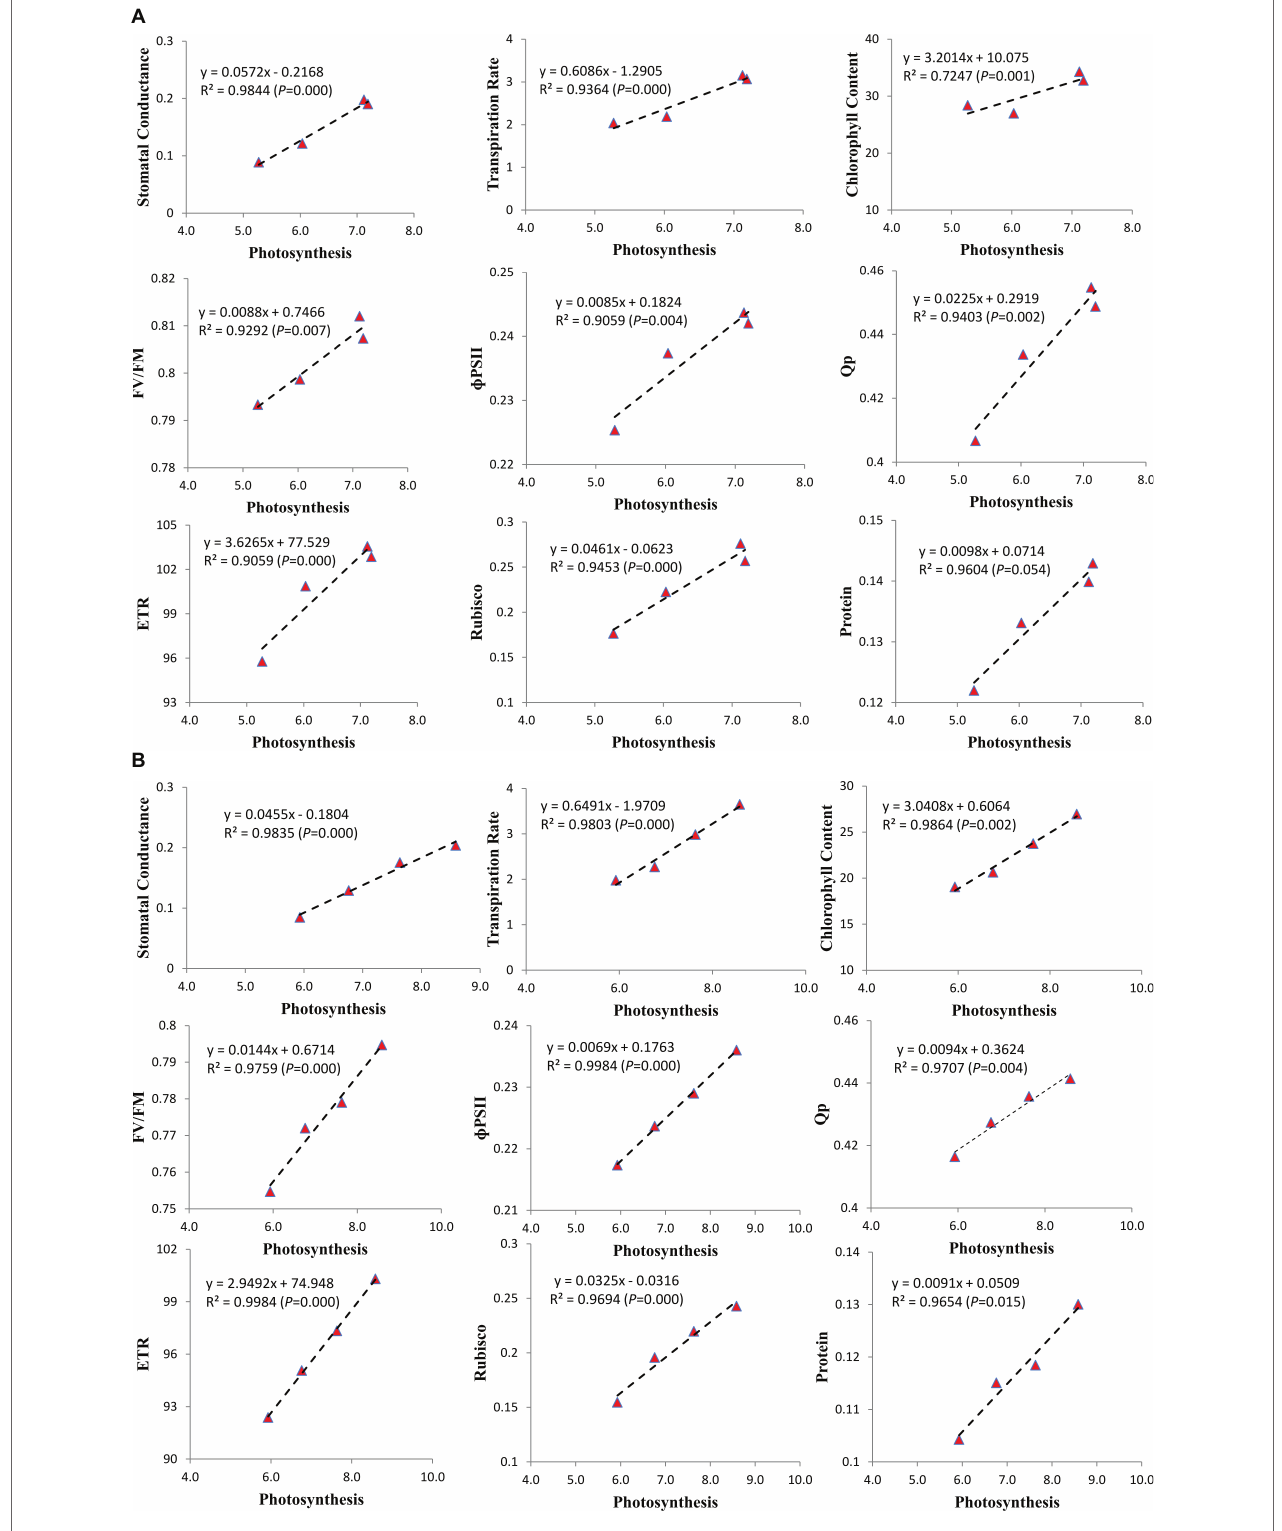
FIGURE 6 | Relationship of photosynthesis with the stomatal conductance, transpiration rate, chlorophyll content, chlorophyll fluorescence parameters, Rubisco activity and protein of soybean seedlings in (A) (ND-12) and (B) (C-103). Correlation coefficients (R) are calculated and significance (P) represents significance at the 0.05